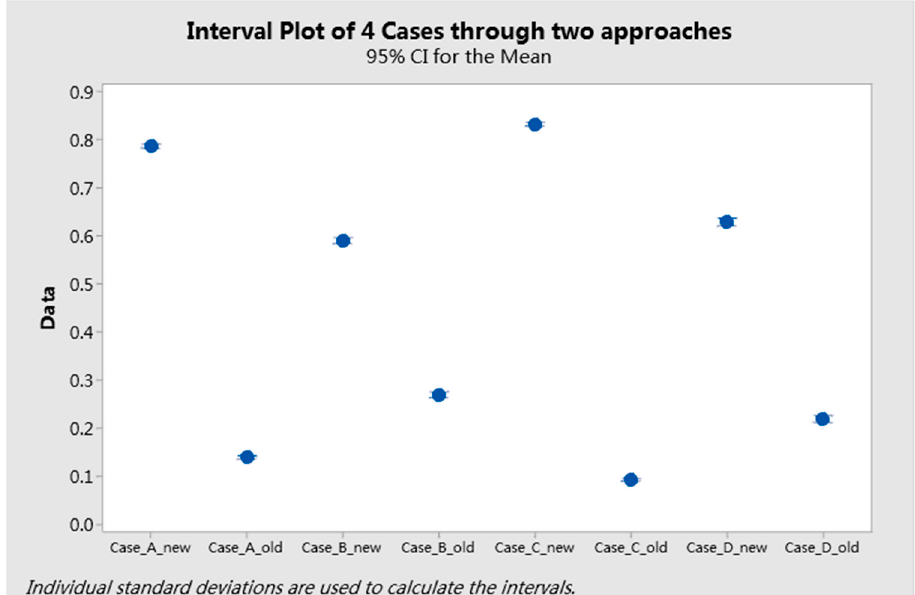
Figure 7. Interval plot of the coverage (data) of 30 times × 4 case results of the two